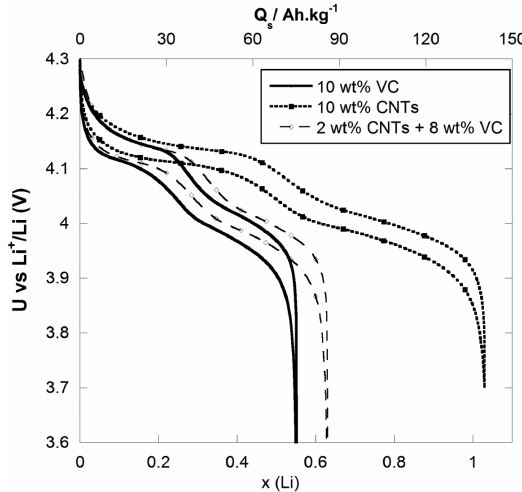
Figure 13. 1 st charge discharge cycle at C/10 rate of nanocomposite electrodes: LMO/10 wt% VC, LMO/10 wt% CNT, LMO/2 wt% VC + 8 wt% VC.